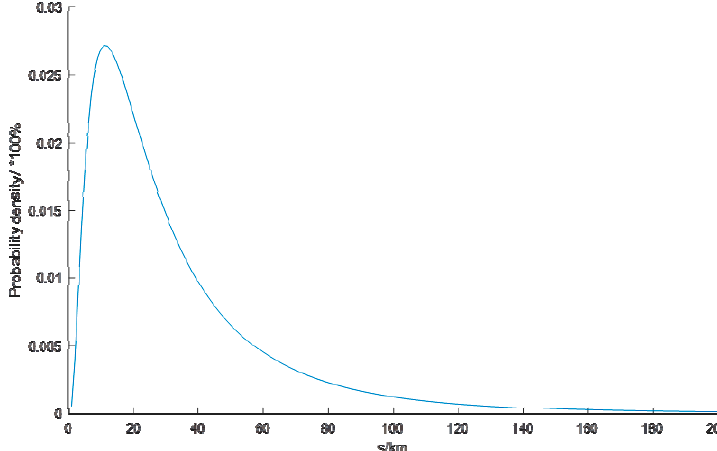
Figure 3. Probability density curve of an EV’s daily travel distance.